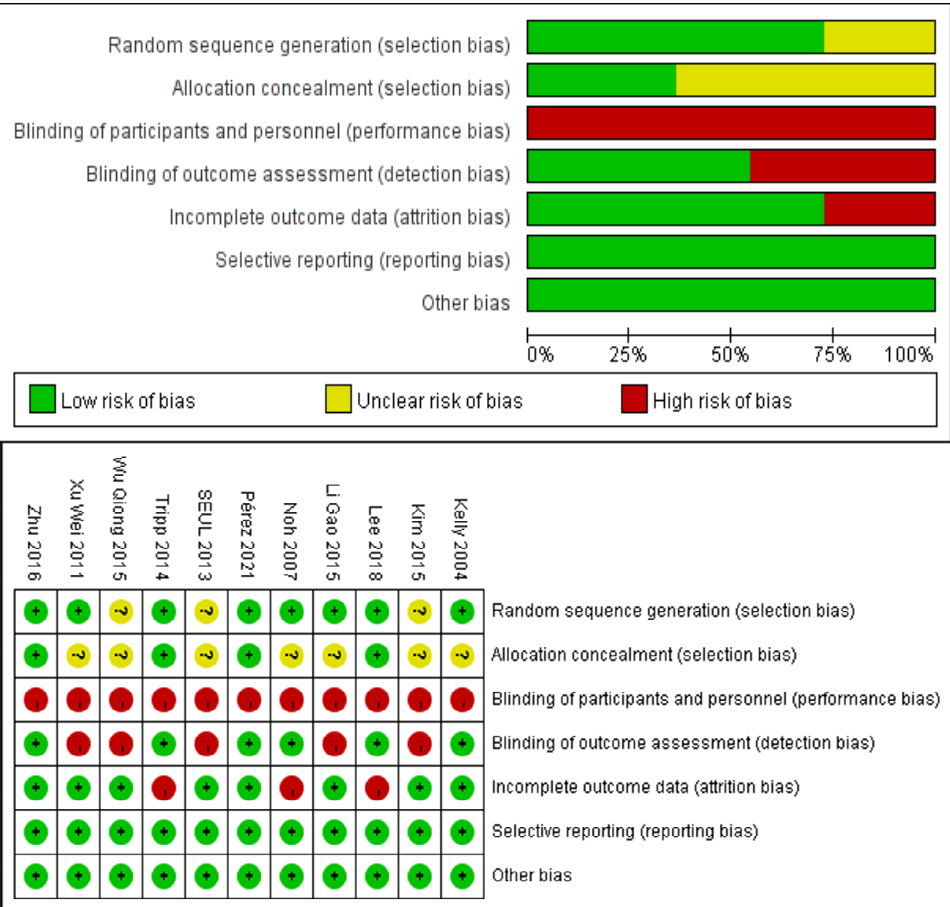
Figure 2. Analysis of the risk of bias in accordance with the Cochrane collaboration guideline.